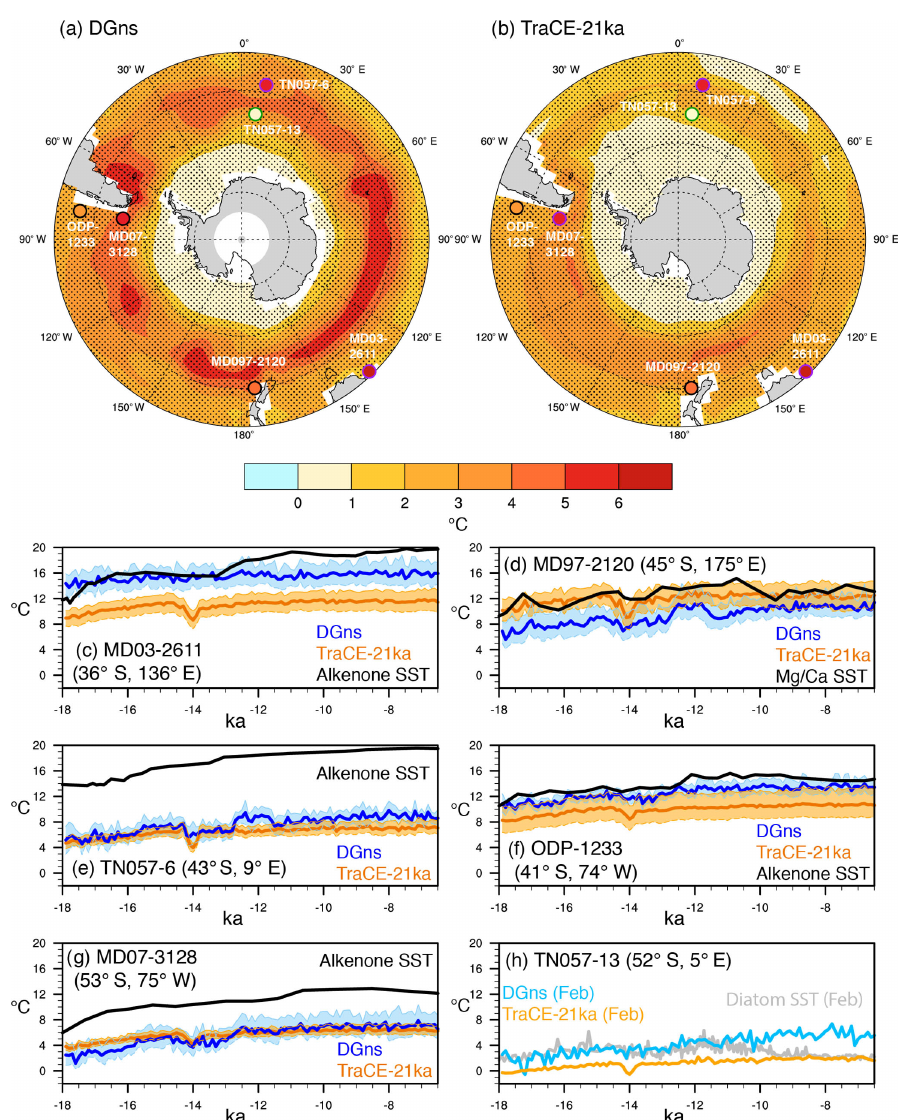
Figure 6. Sea surface temperature (SST) change ( ◦ C) as simulated in (a) DG ns and (b) TraCE-21ka for the period of 18 to 6.5ka (maximum latitude of 35 ◦ S). Dotted lines indicate latitude (intervals of 15 ◦ ) and longitude (intervals of 30 ◦ ). Marine sediment locations are marked by open circles, with black outlines indicating a match in warming between the ice core and model simulation (i.e. the estimated proxy SST change from 18 to 6.5ka is within the range of seasonal SST changes of the climate model) and green (purple) outlines indicating an overestimation (underestimation) in warming by the models. Stippling indicates a difference between decadal output of 18.0–17.5 and 7.0–6.5ka that is significant at the 95% confidence level. (c–h) Time series of 100-year-averaged mean annual SST from the models and SST proxy reconstructions ( ◦ C) at each individual marine sediment core site. The colour shading represents the seasonal range calculated from the 100-year average austral summer and winter temperature anomalies. In panel (h) , only a seasonal (February) proxy reconstruction is available; therefore, we only show modelled February SSTs from the climate models for this